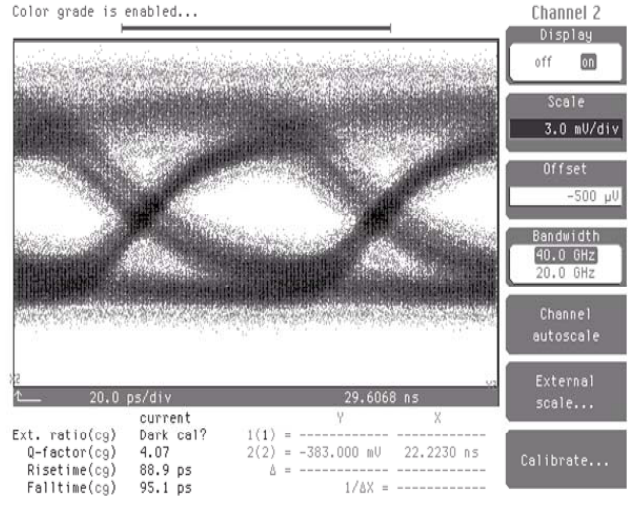
Figure 13. Eye diagram of the monolithically integrated